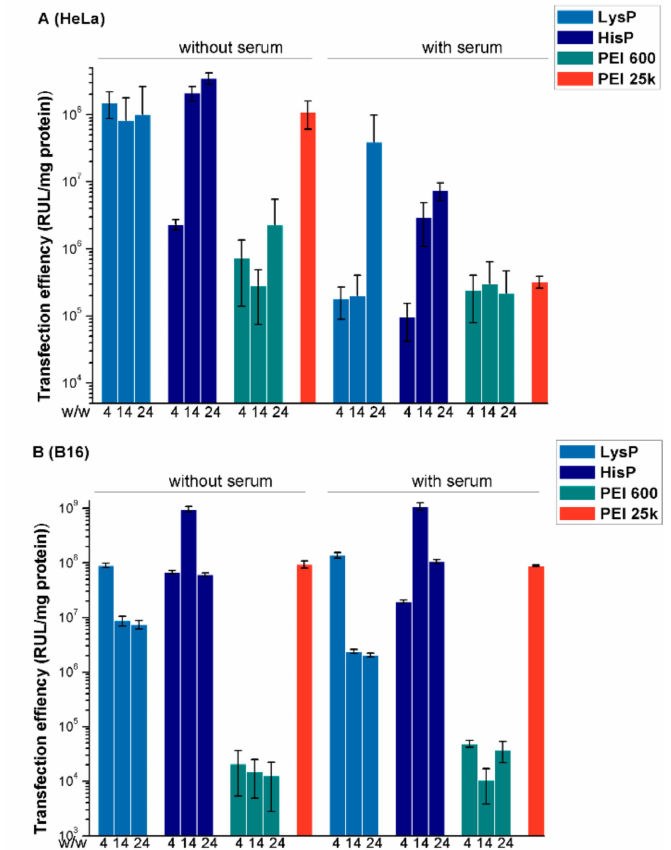
Figure 5. ( A – C ) Luciferase gene expression transfected by polyplexes at di ff erent weight ratios in di ff erent cell lines. ( D ) E ff ect of serum concentration on the transfection e ffi ciency of LysP and HisP at their optimal transfection ratios in B16 cells. PEI 25 kDa ( w / w = 1.4) was used as control.